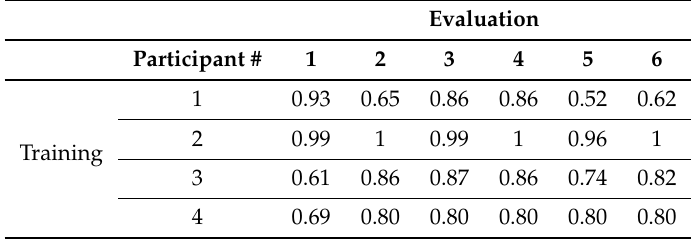
Table 7. Accuracy rates for each combination of training and evaluation participants. Results were obtained through the use of a naive Bayesian classifier on RSS data from a 15-node 433 and 868 MHz network.